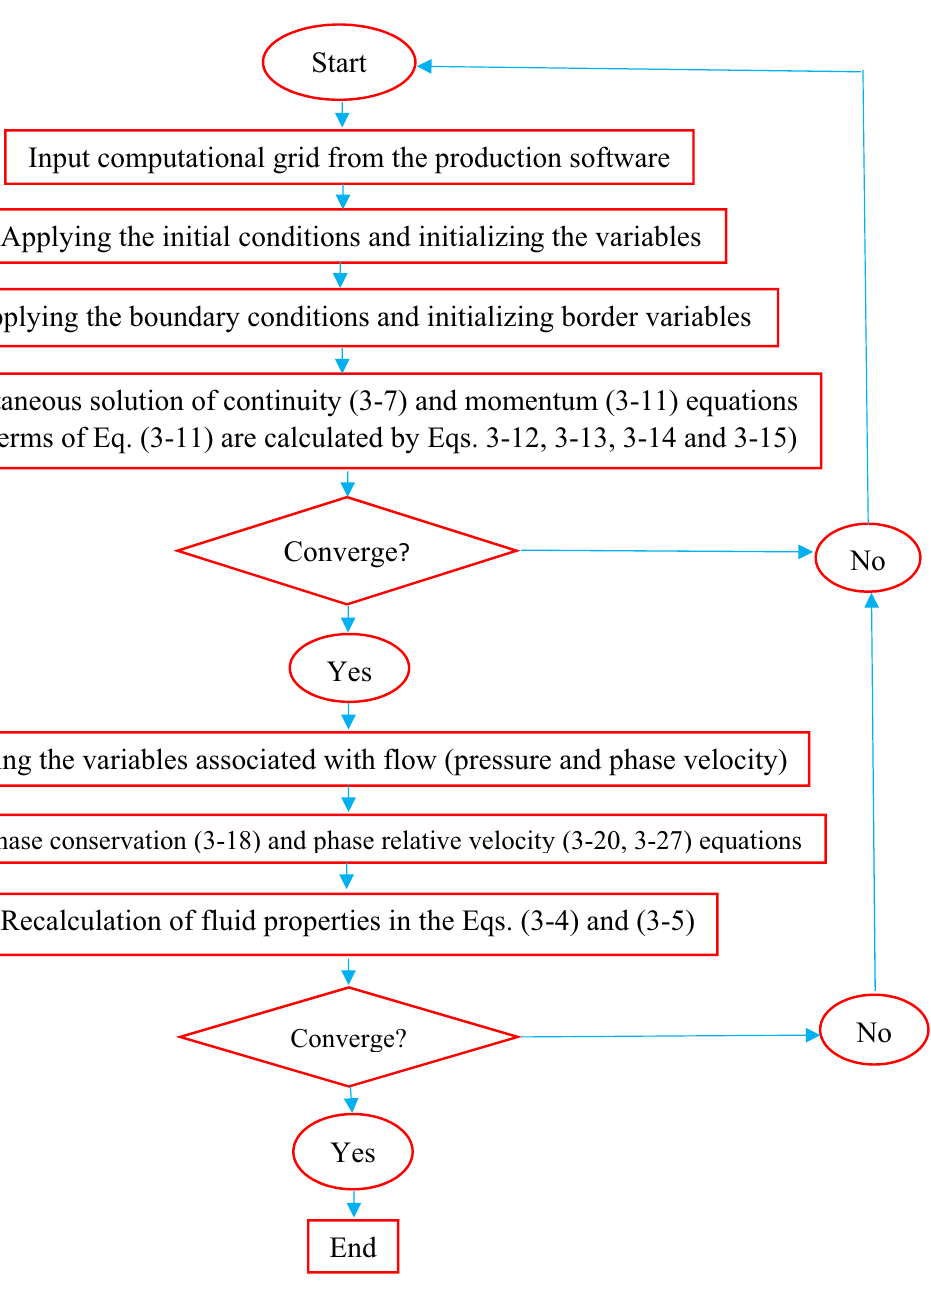
Fig. 8 Solving algorithm of the